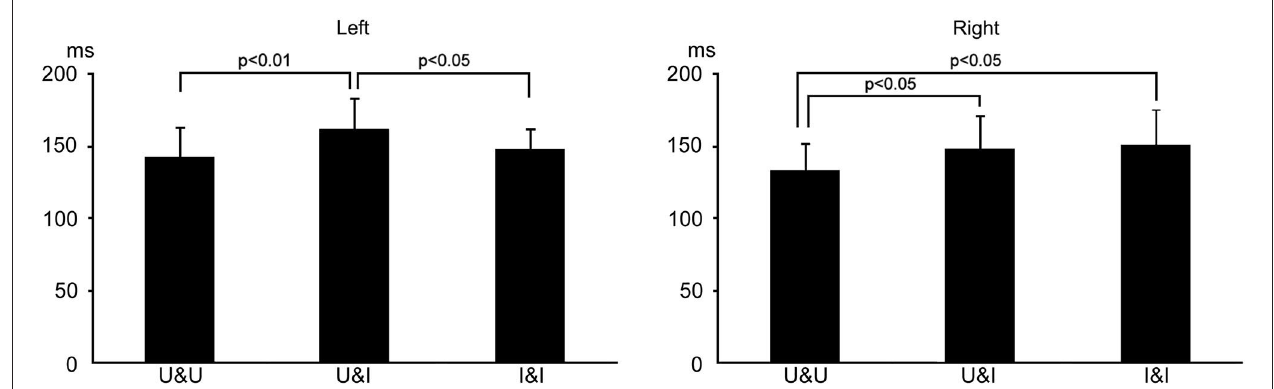
FIGURE 6 | Bar graphs of peak latency for all conditions after S1 onset in the right and left hemispheres . Error bars show the standard deviation (S.D.).